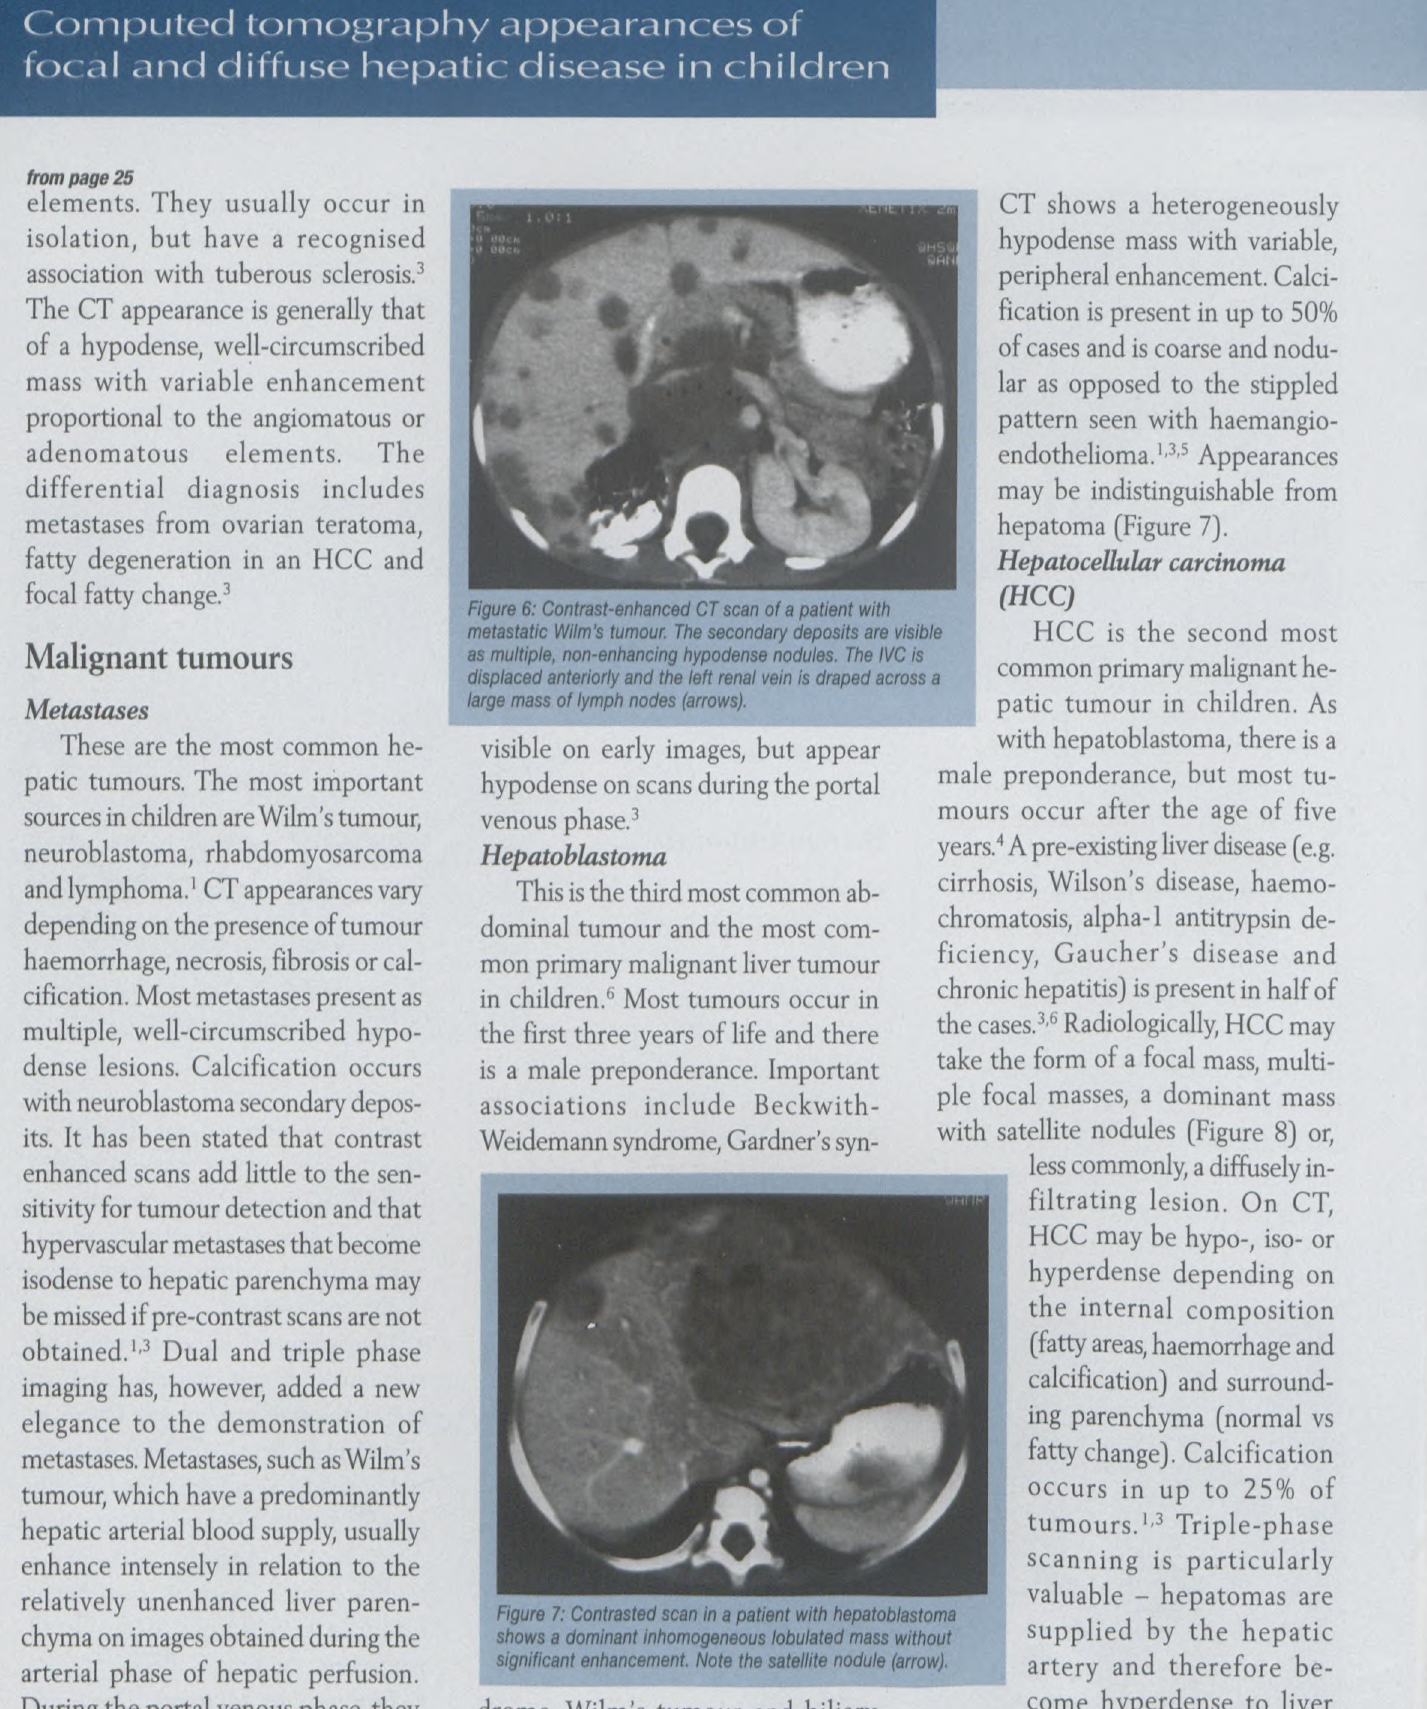
Figure 6: Contrast-enhanced CT scan of a patient with metastatic Wilm's tumour. The secondary deposits ere visible as multiple, non-enhancing hypodense nodules. The IVC is displaced anteriorly and the left renal vein is draped across a large mass of lymph nodes (arrows).